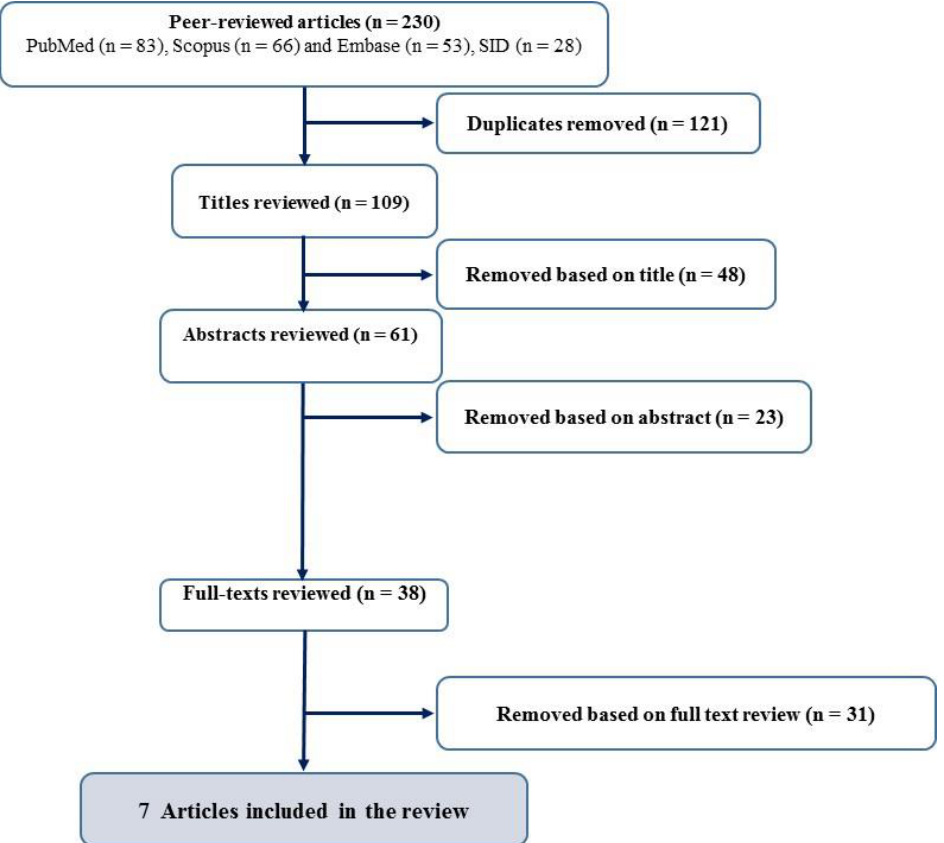
Figure 1. The selection process of articles and inclusion.